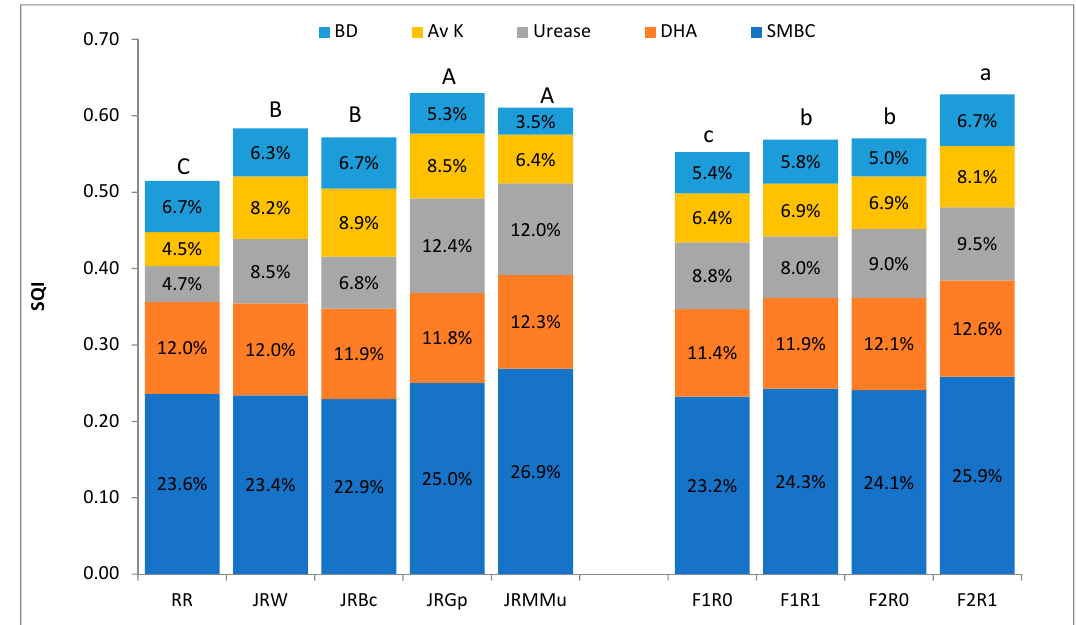
Figure 3. Soil quality index and contribution of soil quality indicator for different cropping system (CS) and nutrient and crop residue management (NRCM) practices. J-Jute, R-Rice, W-Wheat, Bc-Baby corn; Gp: Vegetable pea; M-Mustard, Mu-mung bean (green gram); F 1 R 0 -75% NPK/RDF without crop residue; F 1 R 1 -75% NPK/RDF with crop residue F 2 R 0 -100% NPK without crop residue; F 2 R 1 -100% NPK with crop residue. BD—bulk density; SOC—soil organic carbon; AvK—available K; SMBC—soil microbial biomass carbon; DH—dehydrogenase. Capital and small similar letters mean there are non-significant difference between CS and NRCM, respectively.